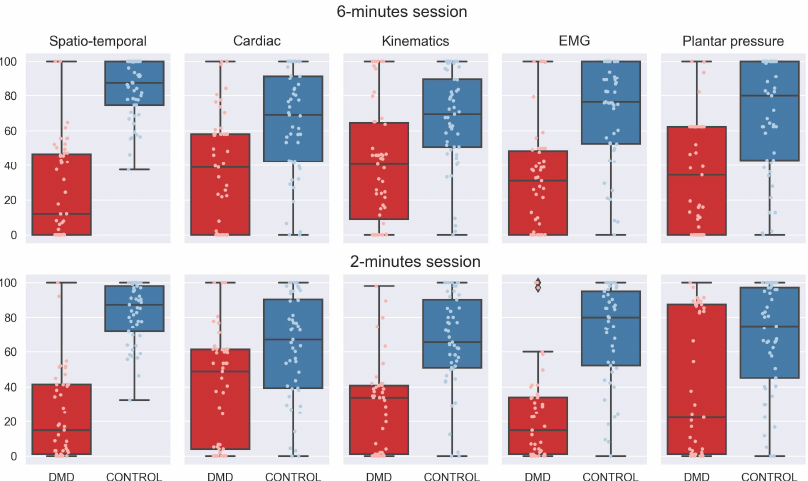
Figure 4. Boxplot distribution for controls (blue) and DMD-affected individuals (red) for each of the scores for the assessed categories, both for 6 and 2 min sessions. Control group achieved scores closer to 100 while DMD group achieved lower scores.